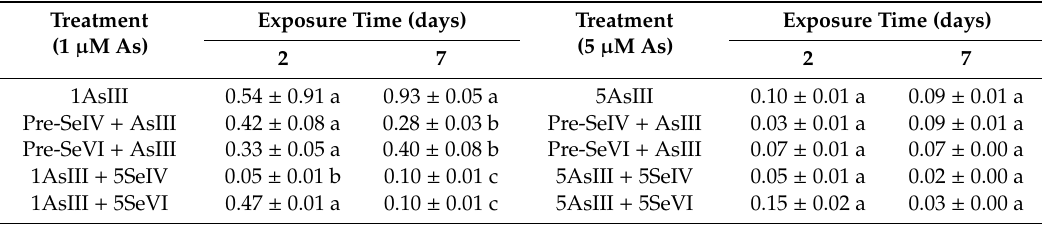
Table 2. Impact of Se pretreatments on the transfer factor of arsenic in rice seedlings treated with As(III).